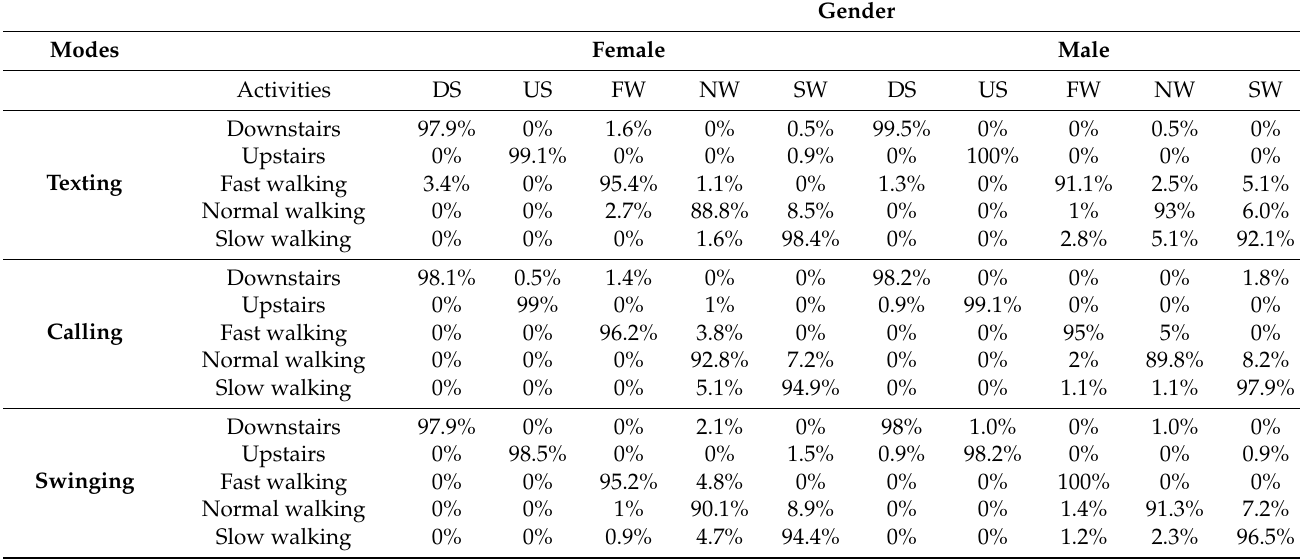
Table 5. Confusion Matrix of the SVM Algorithm.